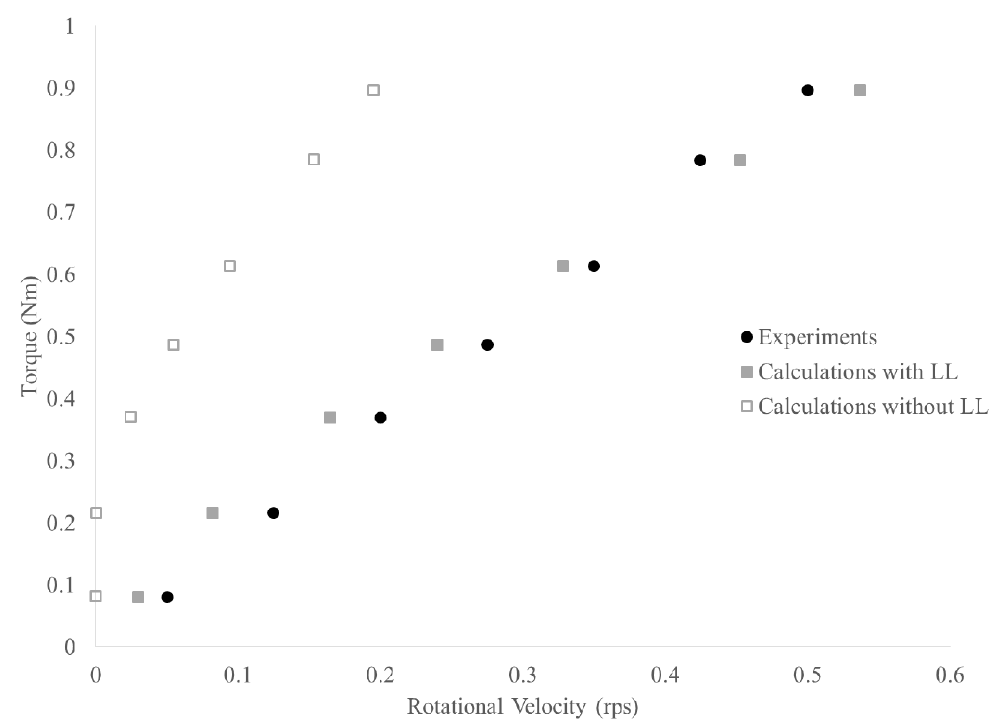
Figure 6. Example of interface rheometer results for mix design 1. The black data is the experiment, the hollow gray points would be the result if the concrete remained homogeneous, while the filled gray points show the best fit with a single mortar layer.